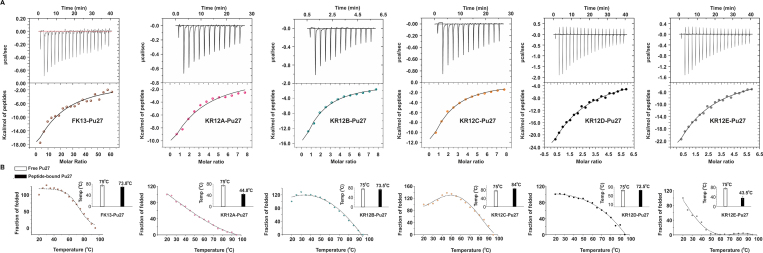
Comparative analyses of the thermodynamic profiling of peptide-Pu27 complexes. (A) Isothermal titration calorimetry showing intermolecular interactions in Potassium Phosphate buffer (pH 7.0) and 100 mM KCl. Top panels: enthalpic heat released versus time at 25°C during titrations. Bottom panels: thermogram of the integrated peak intensities plotted against the molar ratio of the complex. Best-fit curves using single-site binding model. (B) Melting curves of free and peptide-bound Pu27 complex by temperature driven CD (circular dichroism) spectroscopy. Data points denote fraction of folded quadruplex at each temperature. Sigmoidal fitting of the melting curves using two-state transition model (folding and unfolding) yields the melting temperature (Tm). Bar plots denote the Tm of free and bound Pu27.